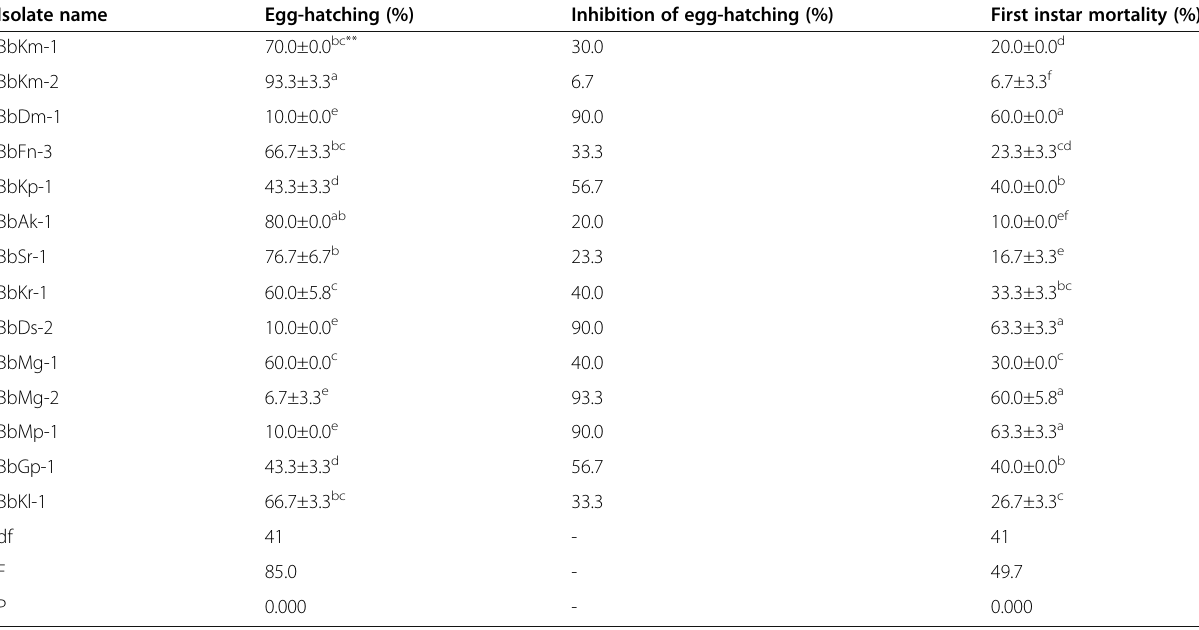
Table 2 Egg-hatching rates of Leptinotarsa decemlineata eggs treated with fourteen indigenous Beauveria bassiana isolates, egg- hatching inhibitory effects of tested fungal isolates, and mortality rates of fed 1st larval instar during molting to 2nd instar